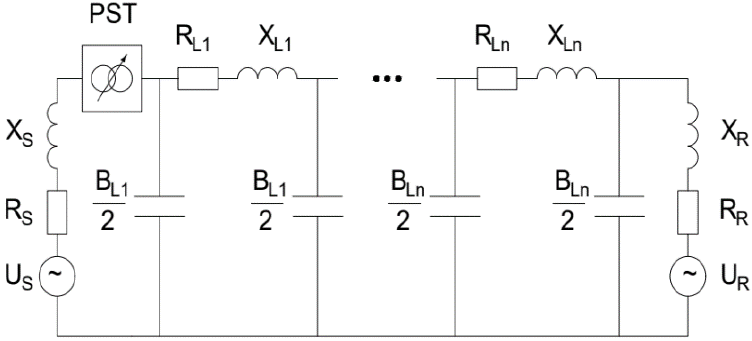
Figure 8. Simplified laboratory testing scheme.